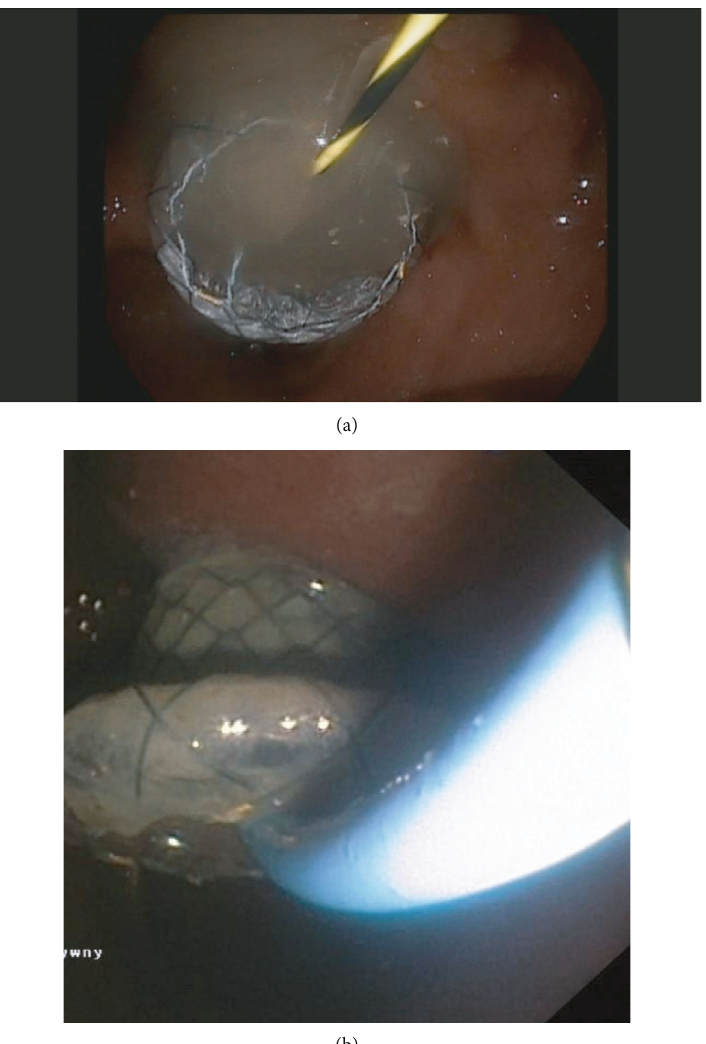
Figure 5: (a, b) Active transmural drainage of a WOPN. After the transmural fi stula is created and a self-expanding stent (LAMS) is inserted transmurally through the fi stula, (b) a nasal drain is introduced along (a) a guidewire into the necrotic